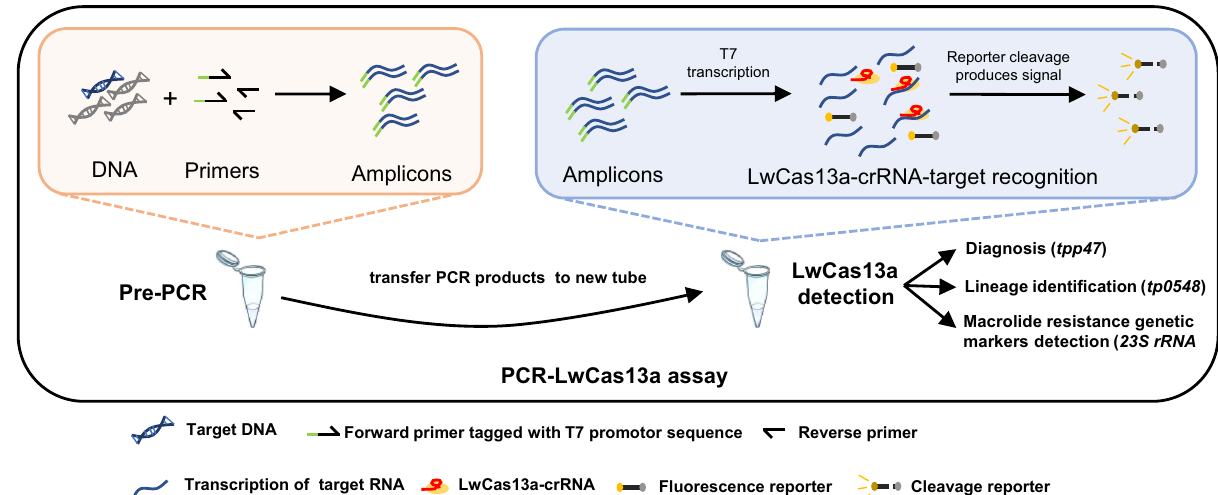
fl uoresces at Ex/Em=490nm/520nm when cleaved. Three targets of TPA were detected in separate reactions in triplicate for diagnosis, identi fi cation of lineage and macrolide resistance genetic markers,